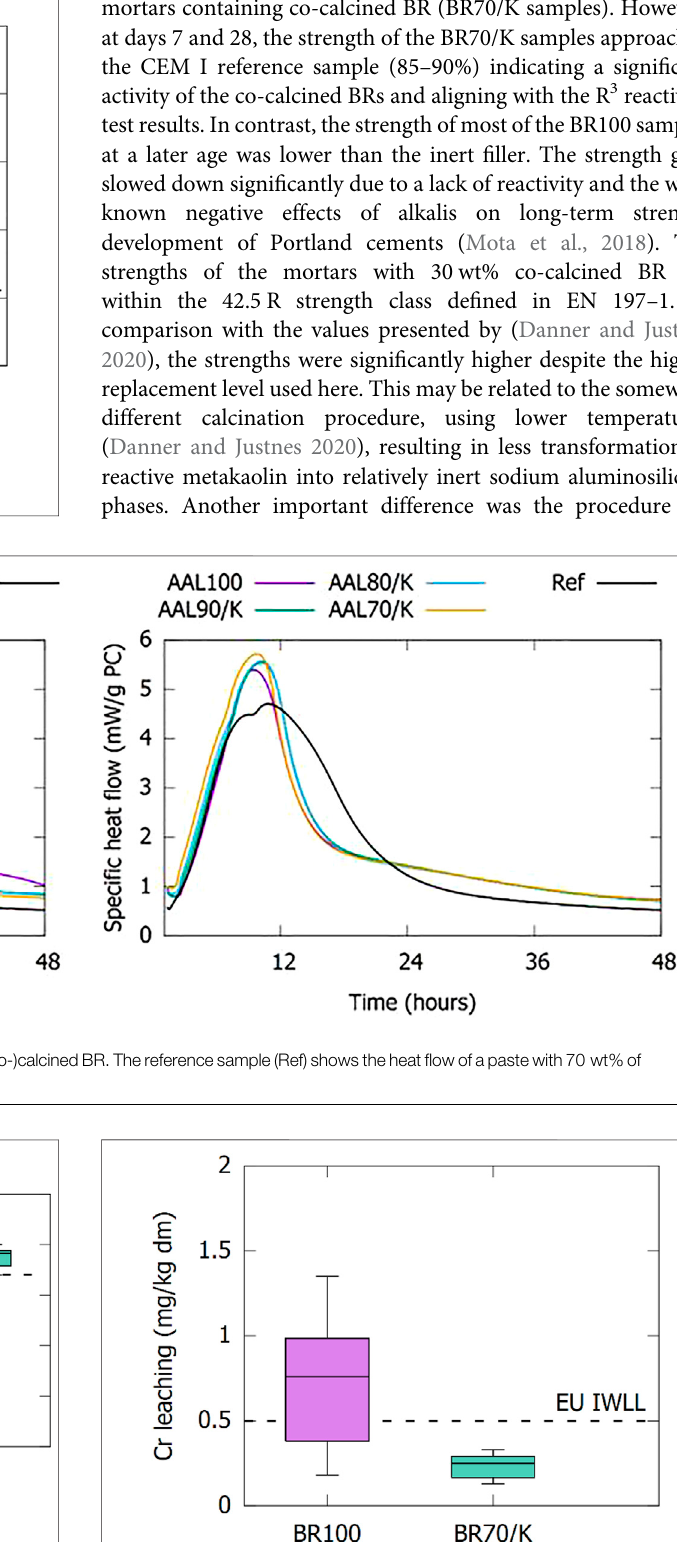
FIGURE 11 | Concentration of Cr in the leachate after batch-leaching in mg/kg dry matter. The leaching of the mortars after 28 days is compared with the EU inert waste leaching limit